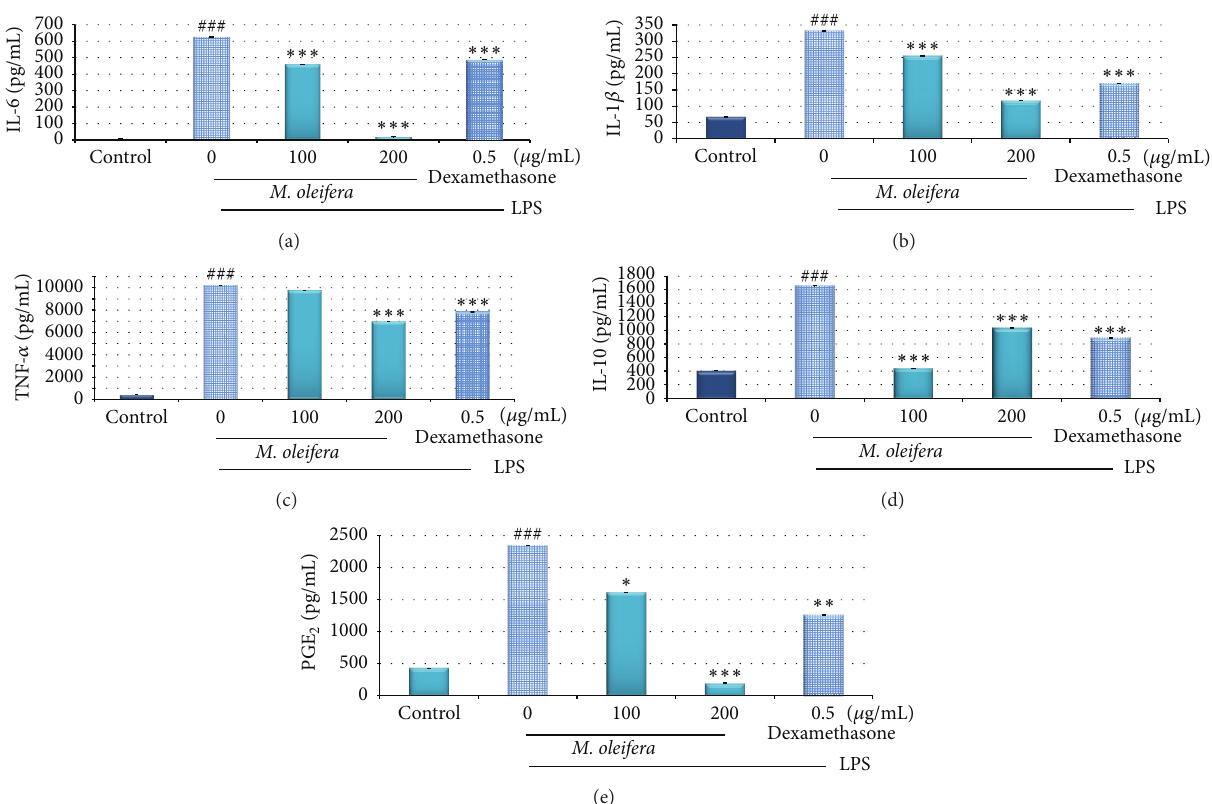
Figure 4: Effect of 80% hydroethanolic M. oleifera bioactive flower extracts on the production of cytokines IL-6, IL-1 𝛽 , TNF- 𝛼 , IL-10, and PGE 2 by LPS-induced RAW 264.7 macrophages. A density of 1 × 10 6 cells/well of macrophages induced by LPS were seeded in 6-well plate and treated with indicated concentrations of flower extract and dexamethasone for 24 h. The supernatants were collected and analysed by ELISA kits. The data are presented as mean ± SD of three independent experiments. ### 𝑝 < 0.001 : LPS-treated group versus control; ∗∗∗ 𝑝 < 0.001 , ∗∗ 𝑝 < 0.01 , and ∗ 𝑝 < 0.05 : treated group significantly different from LPS-treated group. Control: basal level of cytokines released without LPS